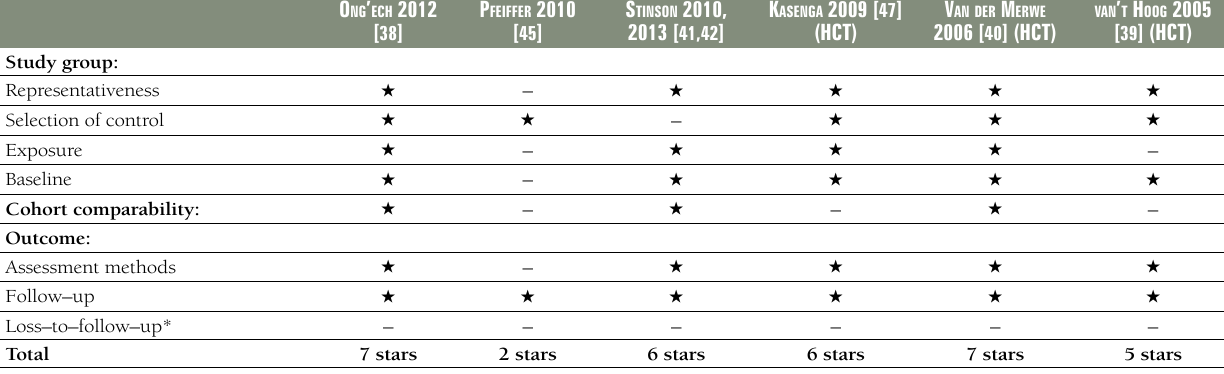
Table 3. Risk of bias assessment for included NRS based on the Newcastle–Ottawa